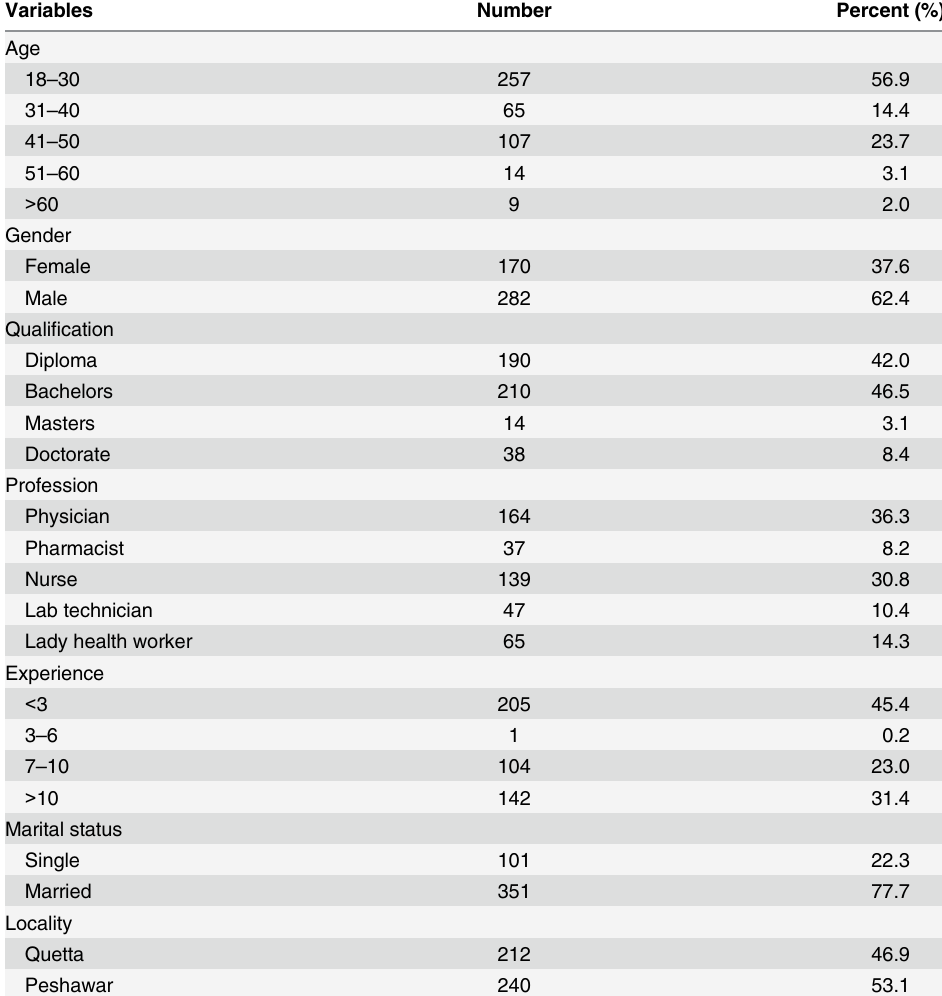
Table 1. Demographic information of the